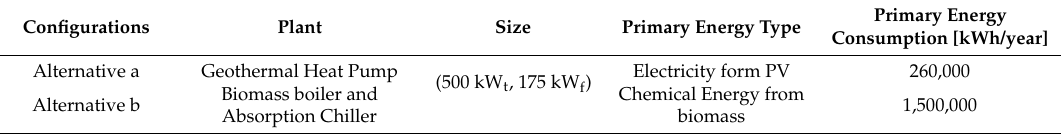
Table 11. Energy requirements for heating and cooling referred to each